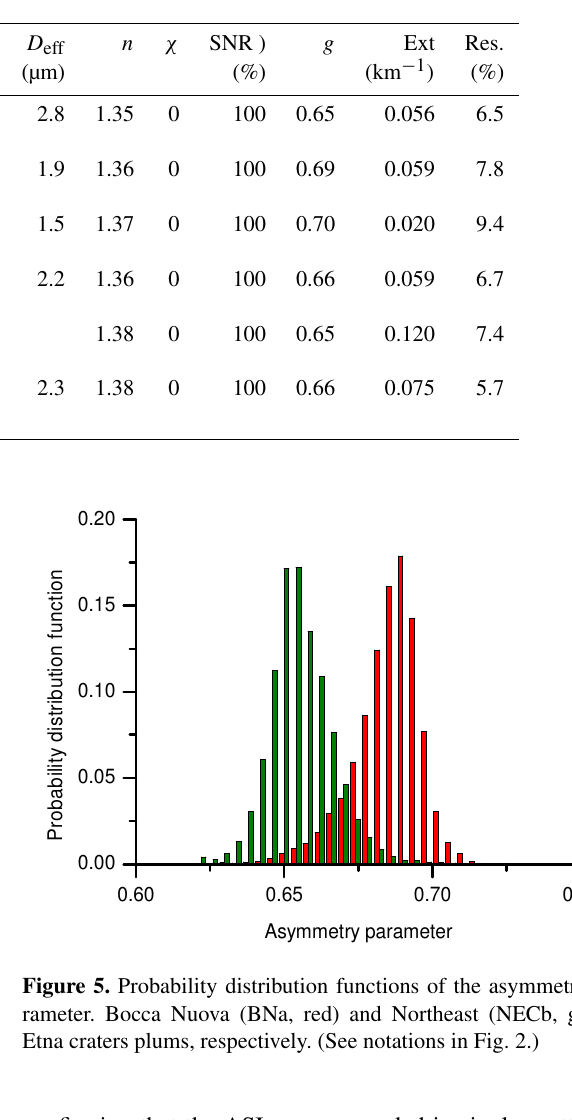
Table 1. Mean parameter values in the indicated time intervals (see Fig. 1). The parameters are time interval, altitude, air temperature T , relative humidity with respect to water (RH w ) ; concentration (Conc) of particles ( d > 0.9µm), and effective diameter D eff measured with the FSSPs; real n and imaginary χ part of the refractive index, spherical/nonspherical partitioning ratio (SNR), asymmetry parameter g , extinction coefficients (Ext), and residual (Res) estimated from the retrievals data. (See notations in Fig. 2.)